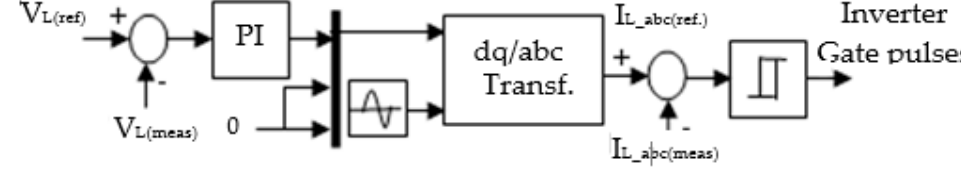
Figure 5. Block diagram of the inverter controller.